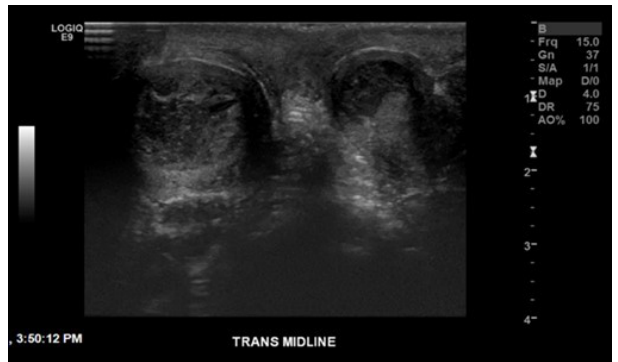
Figure 4. Cross-sectional scrotal ultrasound done approximately one month post-operatively demonstrates decreased volume of both testicles.